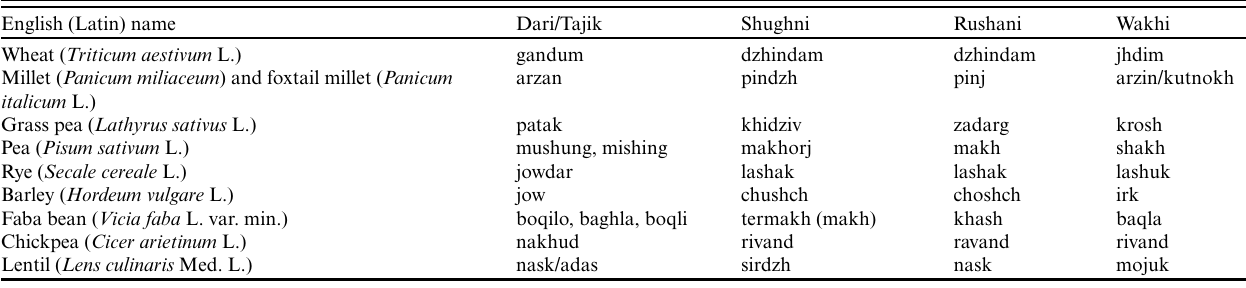
Fig. 1. A field of lashak-makh (rye-pea) in the village of Gorzwinj, in the Afghan Pamiri valley of Shughnan. The Pamiri name for rye tells a story itself: lashak comes from the word ara-lashak, which means “mixed with.” Rye is never grown alone, always together with other grains or pulses. This is also how it grows naturally, as a common weed supplanting wheat or barley, which are less hardy in the poor mountain soils. Vavilov (1997) noted that the Pamirs are one of the few places in Asia where rye was grown deliberately as a domesticated crop. In the rest of Afghanistan, for example, where it was not eaten, it was called gandum-dora, “a plant that infests barley or wheat”. Photograph by Judith Quax.